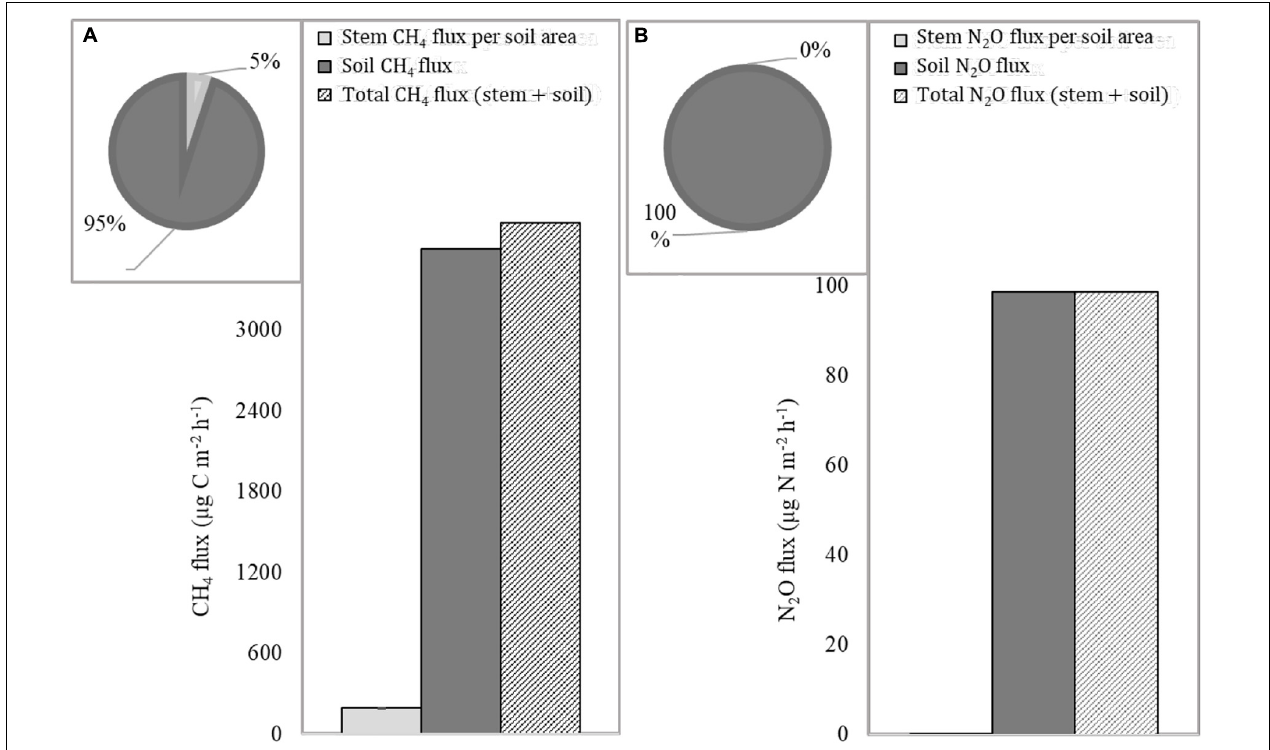
FIGURE 3 | Average soil, stem, and total CH 4 (A) and N 2 O (B)